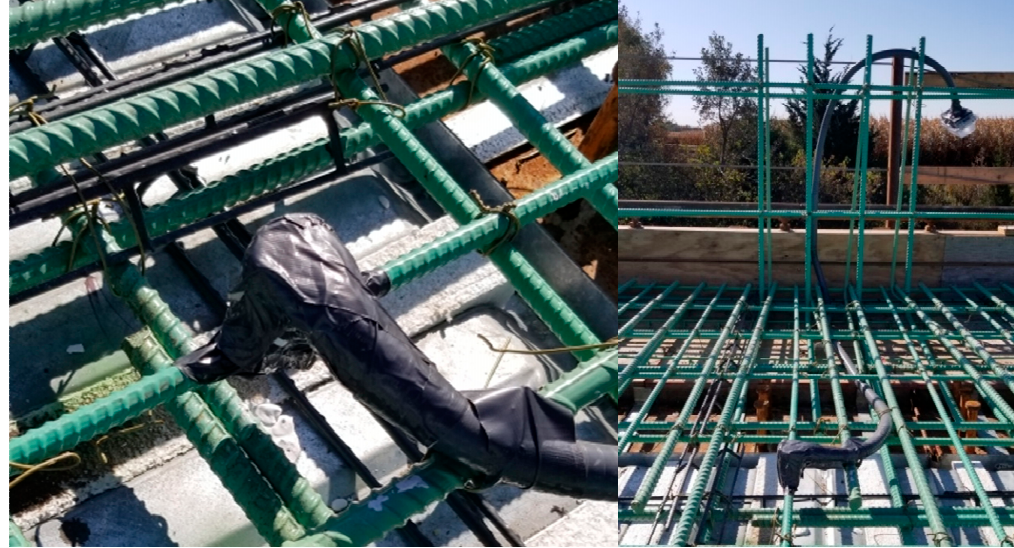
Figure 22. Valparaiso Bridge instrumentation. Left: gypsum seat attachment of the ultrasonic transmitter wrapped in duct tape. Right: the sensor cable was protected in protective plastic pipe and ran to the shoulder of the bridge.